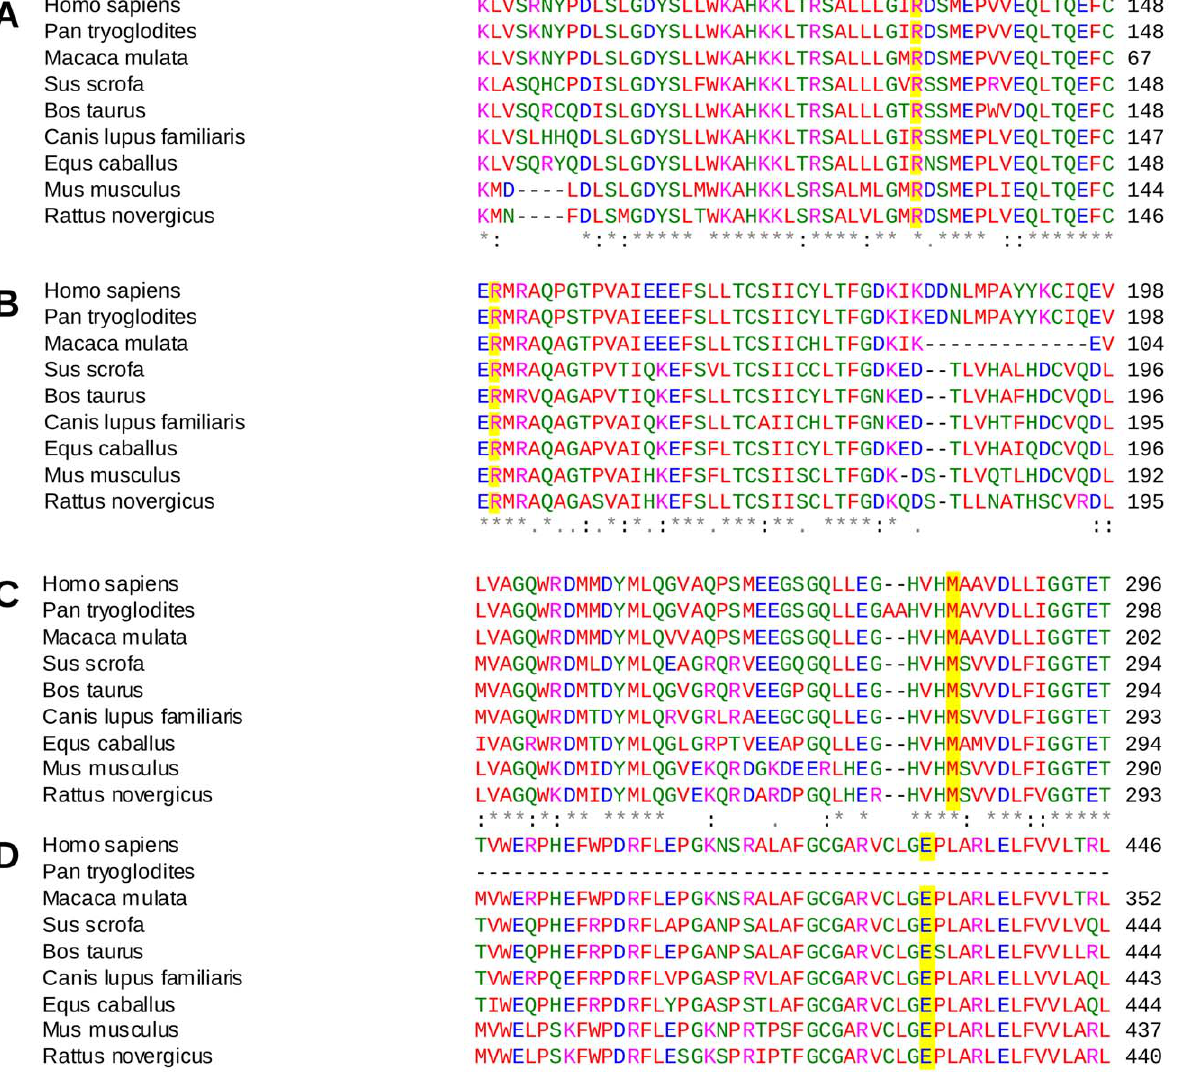
Figure 2: Partial Clustal W alignment analyses of CYP21A2 proteins from different mammalian species. The residues of each mutation are highlighted in yellow. A: R residue at position 132. B : R residue at position 149. C . M residue at position 283. D: E residue at position 431.